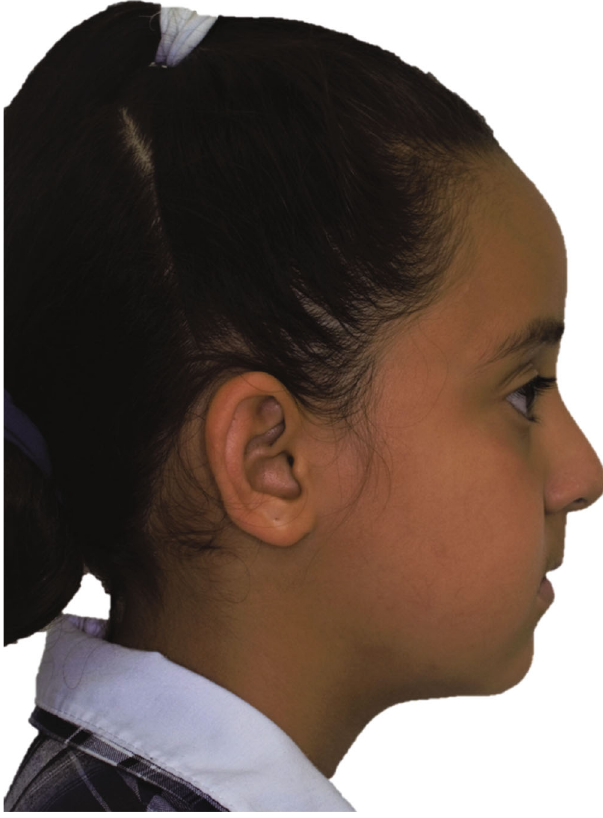
Figure 2: There is a greater predominance of the upper third of the face with respect to the middle and lower thirds. A slightly fl attened mentolabial angle is